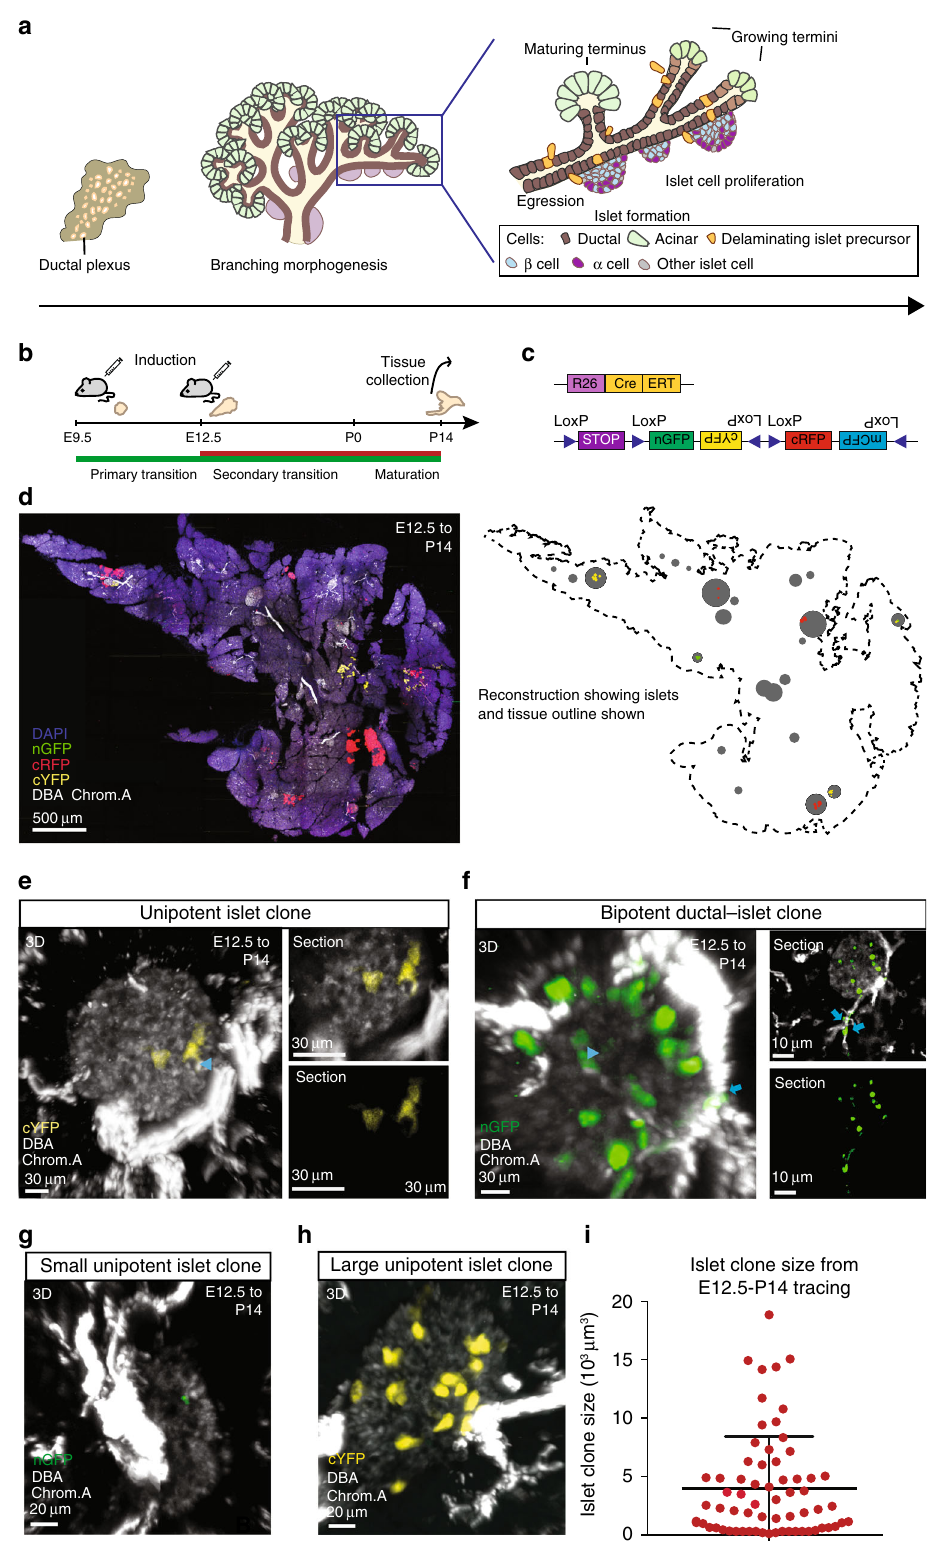
Reconstruction showing islets and tissue outline